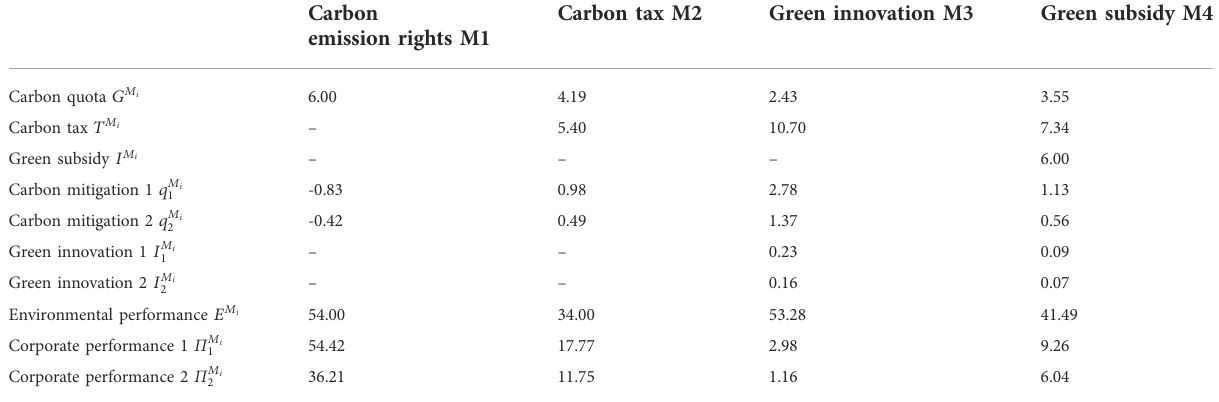
TABLE 3 Equilibrium points for carbon